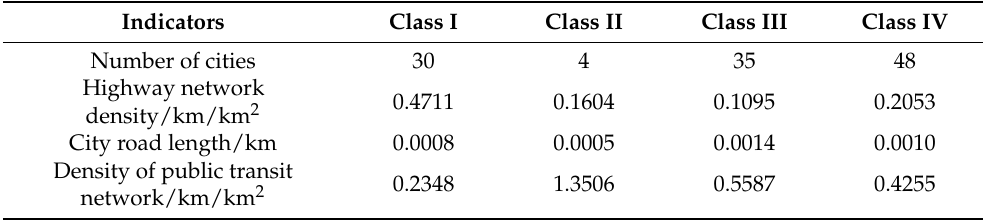
Figure 8. City clustering partitioning results. Table 5. Mean statistics of clustering